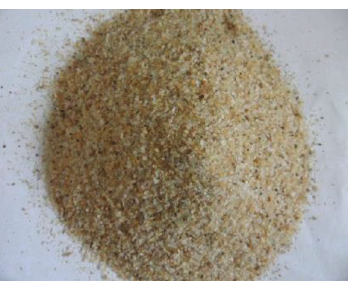
Figure 1: China ’ s ISO standard sand. Table 2: Physical properties of standard